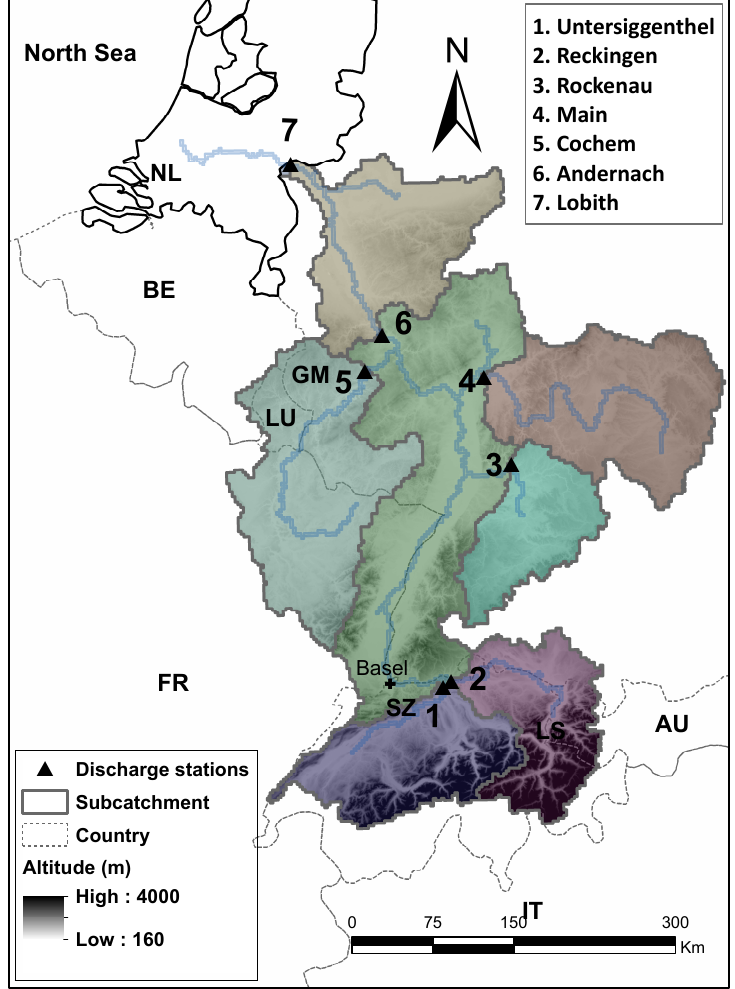
Figure 1. The Rhine basin, with seven sub catchments used for the